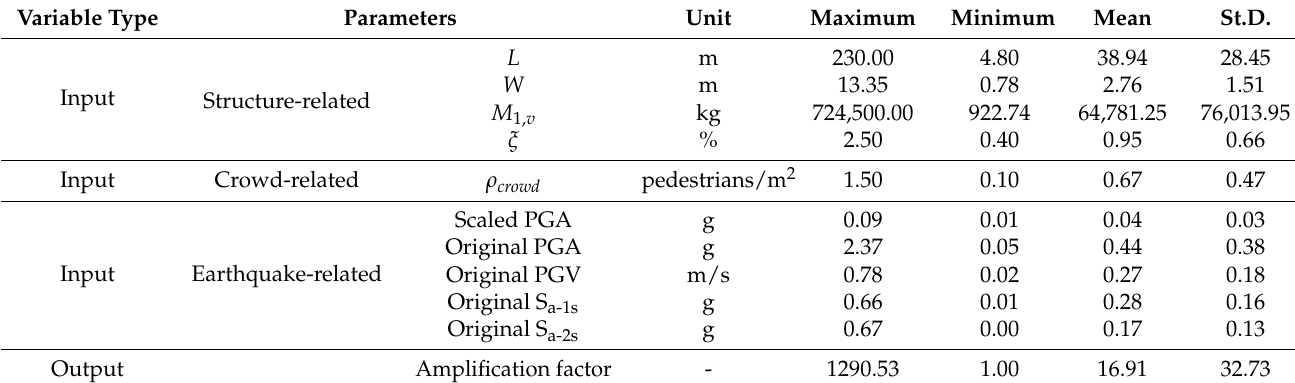
Table 6. Statistical values of input and output variables.